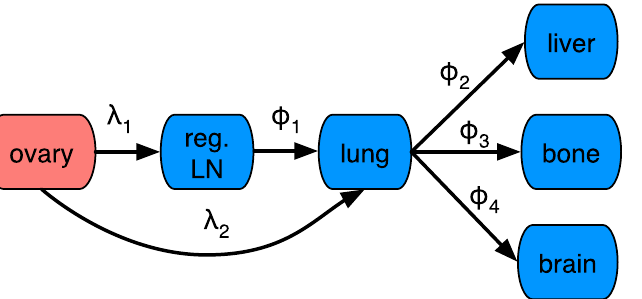
Fig 3. The dissemination network for ovarian cancer. The tumour cells spread either via regional lymph nodes or directly to the lung where they form metastases. From there further dissemination to the liver, bone and brain occurs.